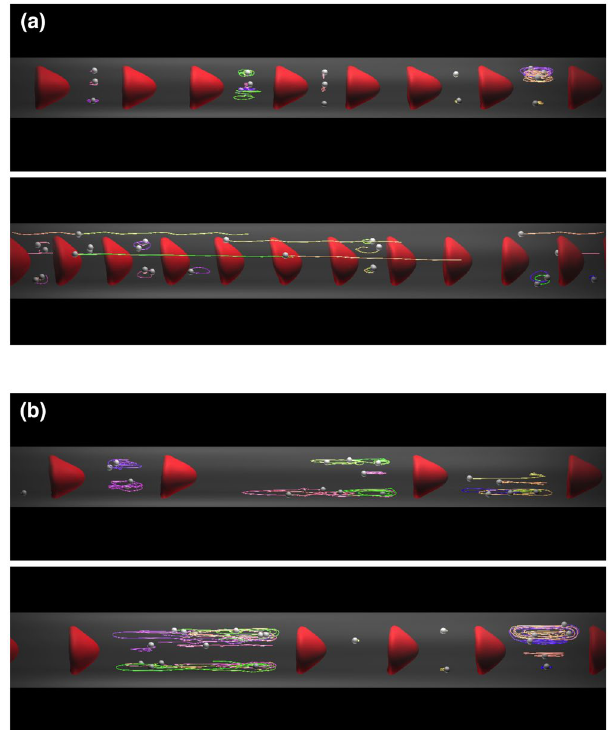
Figure 4. Snapshots of the flow of MPs and RBCs for Ca = 0.2 and ( a ) Hct = 0.1 and ( b ) 0.05 in capillaries with diameters (top) D = 10 μ m and (bottom) 12 μ m. See also Supplemental Movies S5 and S6.